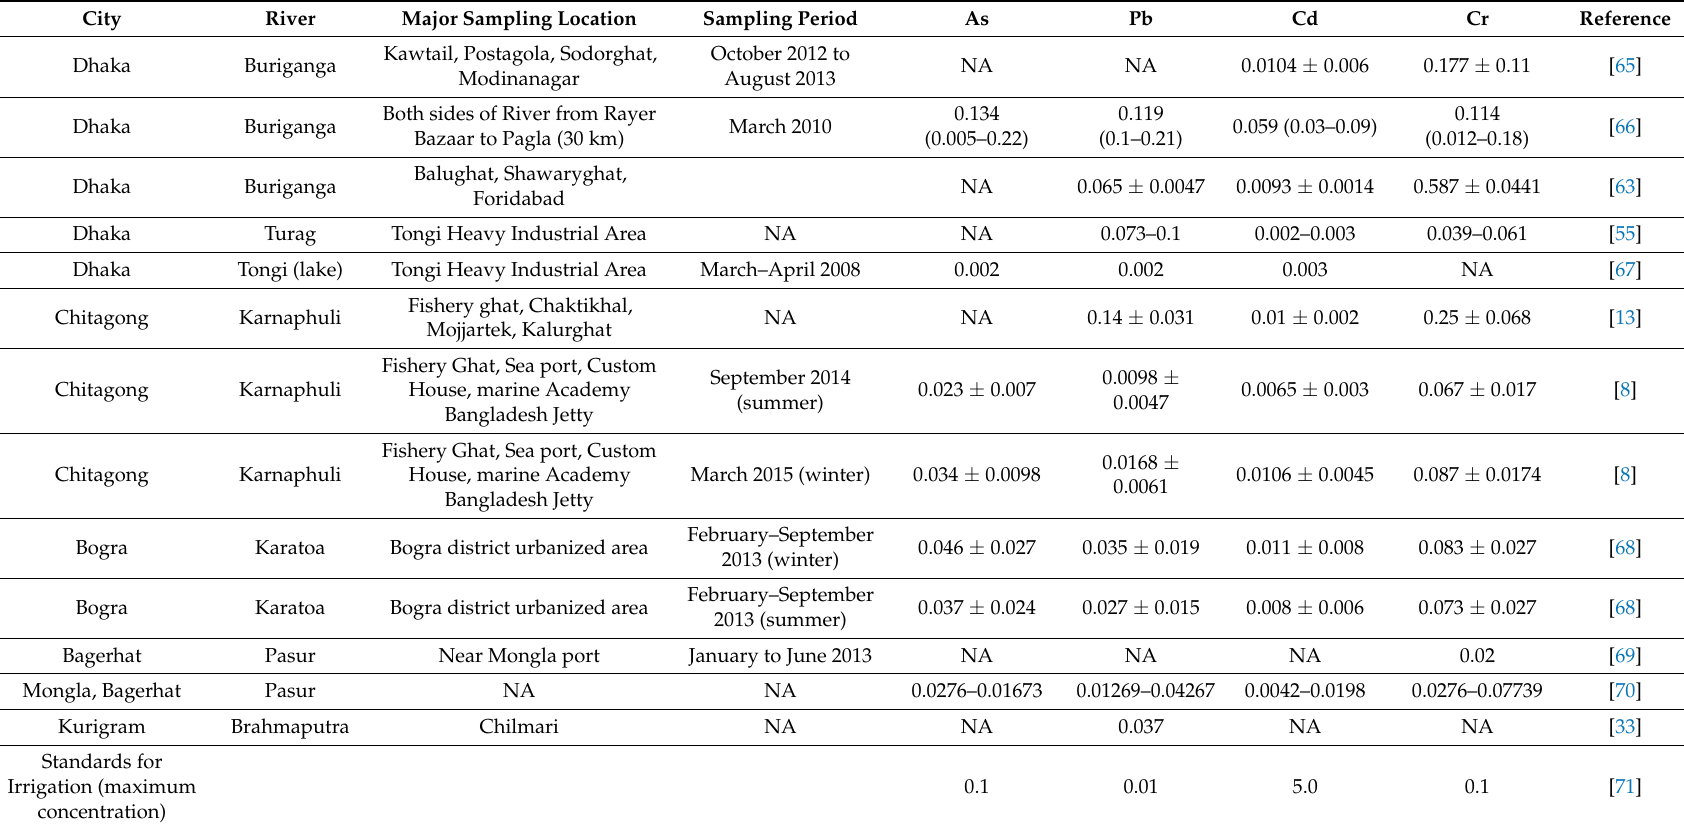
Table 2. Heavy metals and metalloids pollution in major Bangladesh rivers